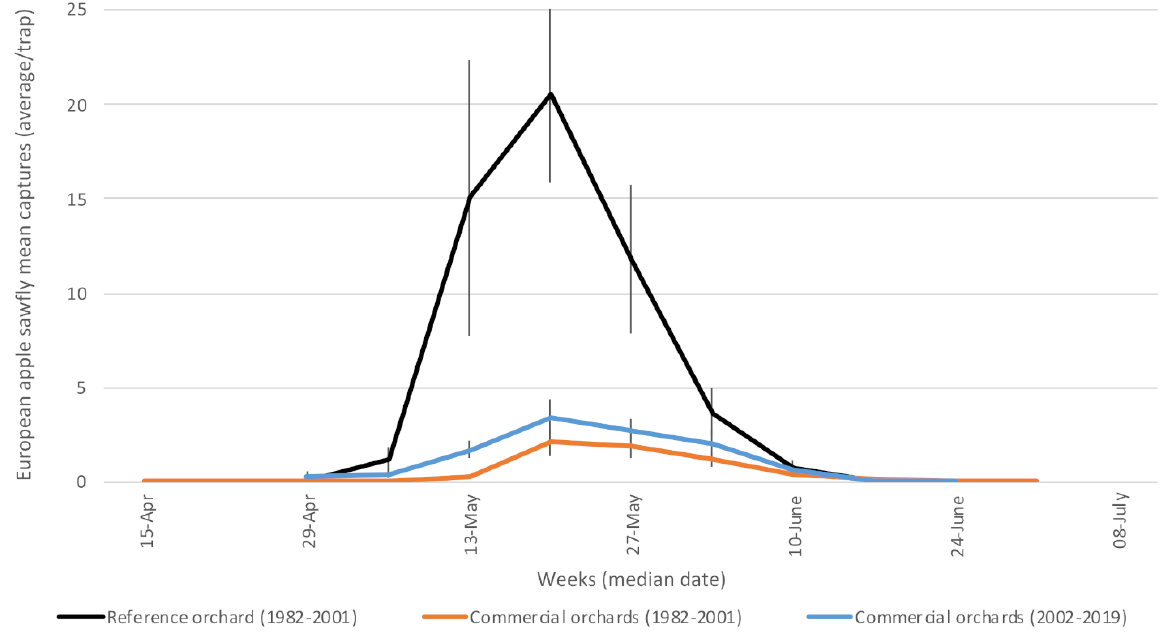
Figure 3. Average captures of European apple sawfly adults in participating orchards. Reference (insecticide-free) orchard located at Frelighsburg, Qc (Agriculture and Agri-Food Canada, 1982–2001). Commercial orchards located at Franklin, Hemmingford, Oka, Rougemont and Saint-Paul-d’Abbotsford. Vertical bars represent standard error.